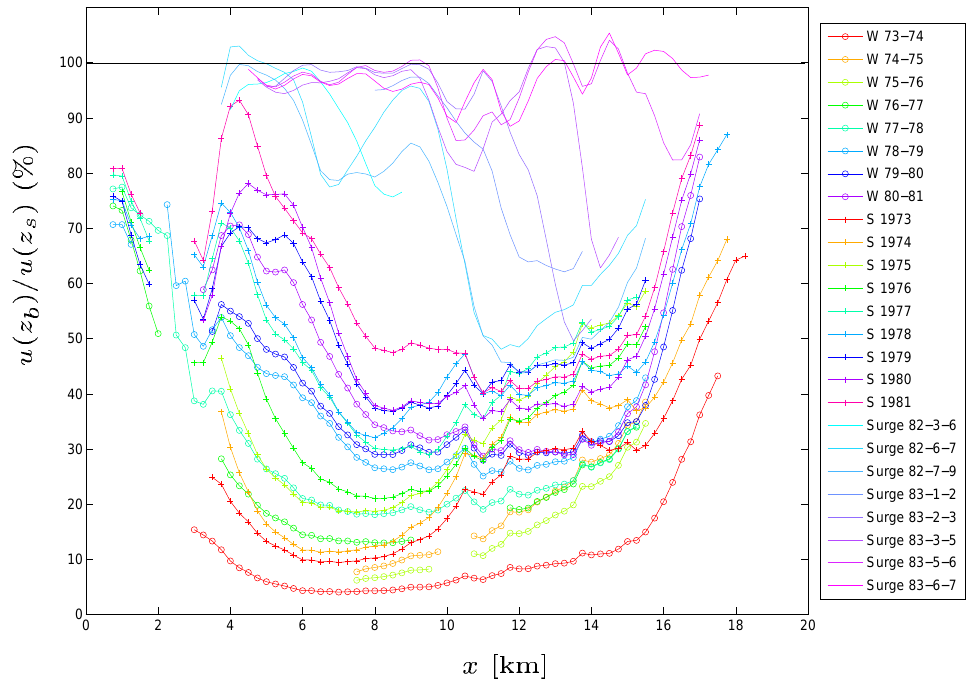
Fig. 5. Distribution of the ratio of the modelled horizontal basal velocity u(z b ) over the surface velocity u(z s ) along the central flow line for the 25 dates of measurements. Results are shown only where velocity has been measured. For the legend, see caption of Fig. 4